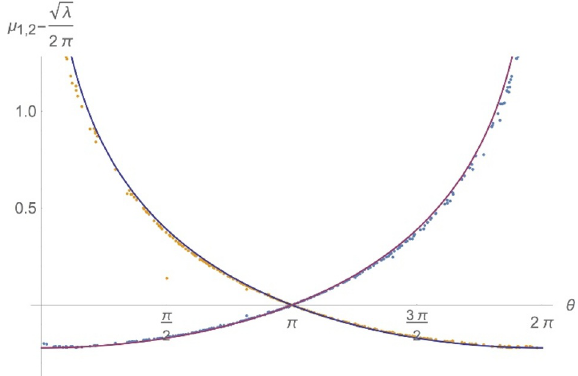
p (cid:21)= 2 (cid:25) , as functions of the p (cid:21)